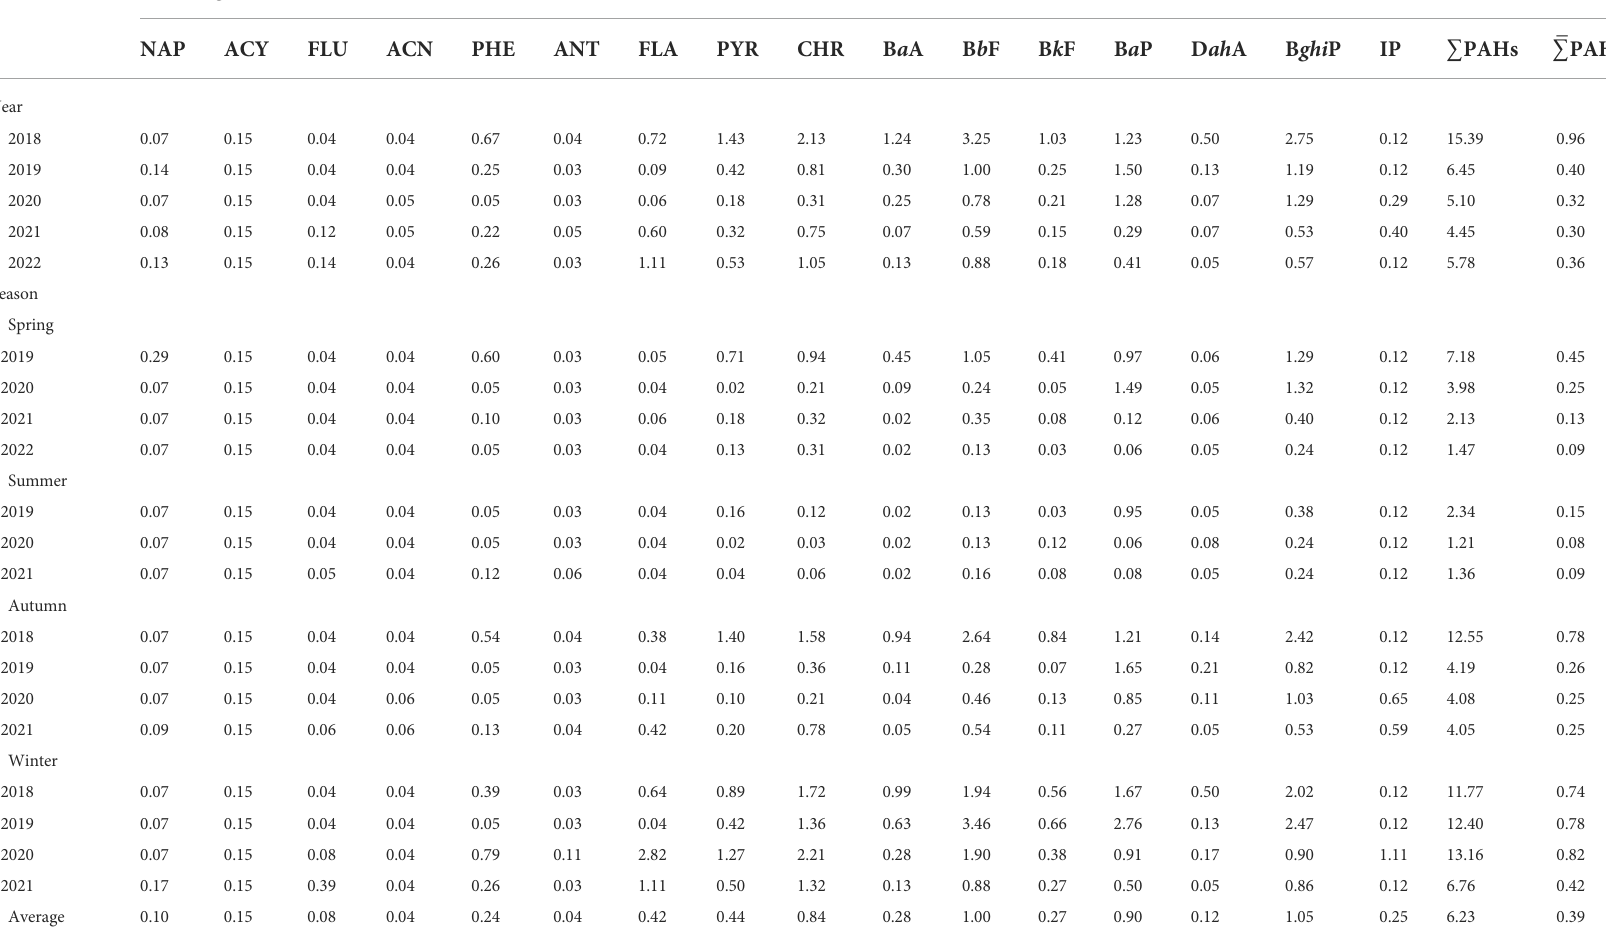
TABLE 2 Average mass concentration (ng/m 3 ) of 16 PAHs in PM 2.5 from 2018 to